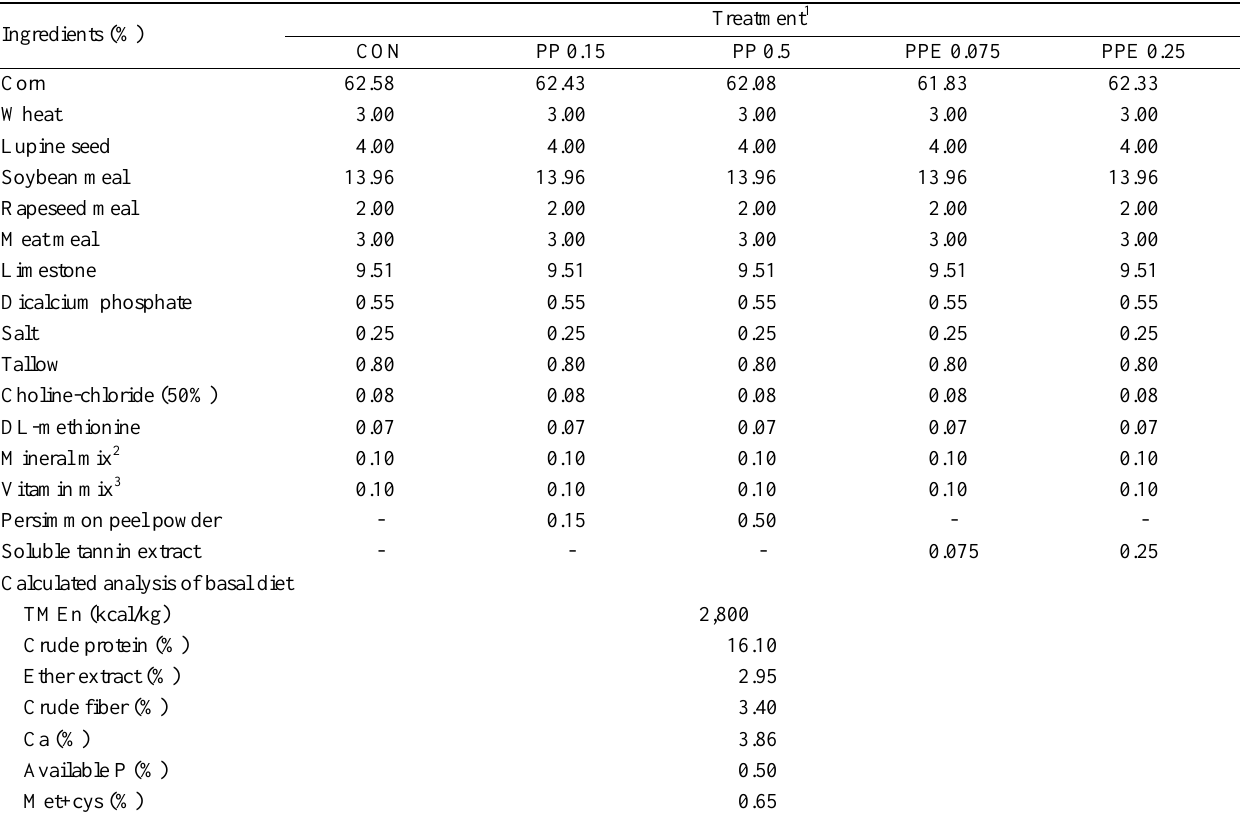
Table 1. Formula and chemical composition of the experimental diet Ingredients